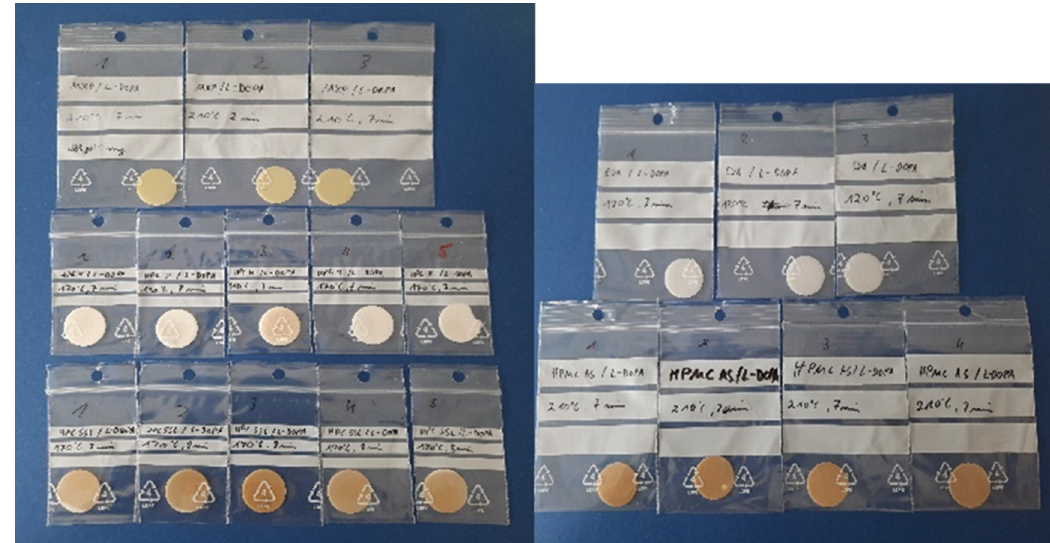
Figure 1. VCM platelets of different SR polymers.